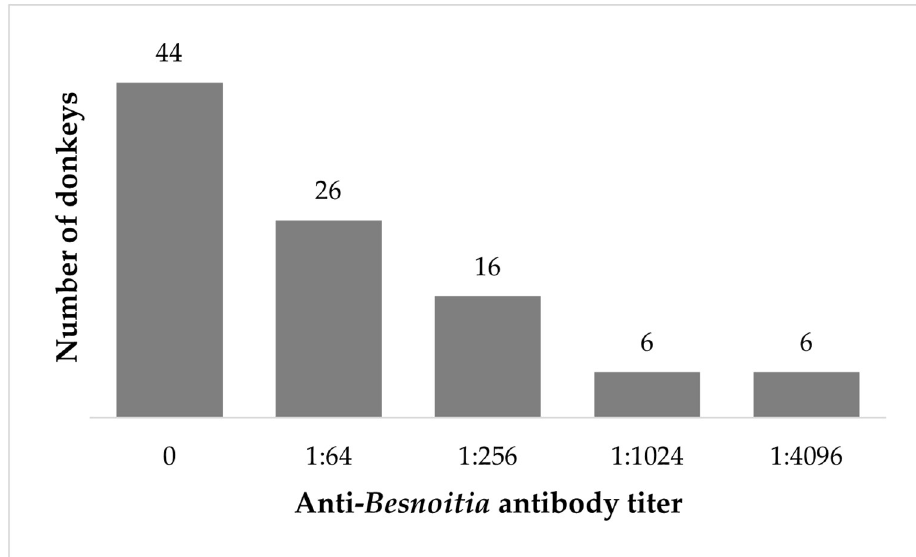
Figure 2. Anti- Besnoitia spp. antibodies titer in positive donkeys. The numbers above the bars represent the number of donkeys that were seropositive in the end point titer.